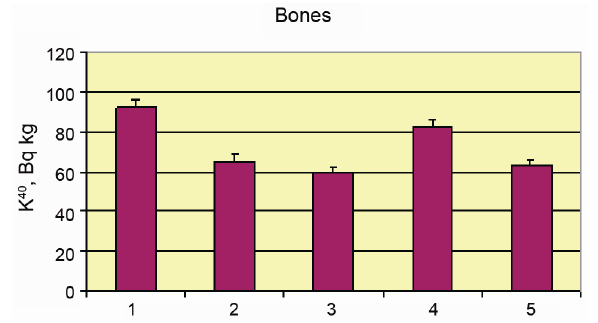
40 K in fox bone tissues: